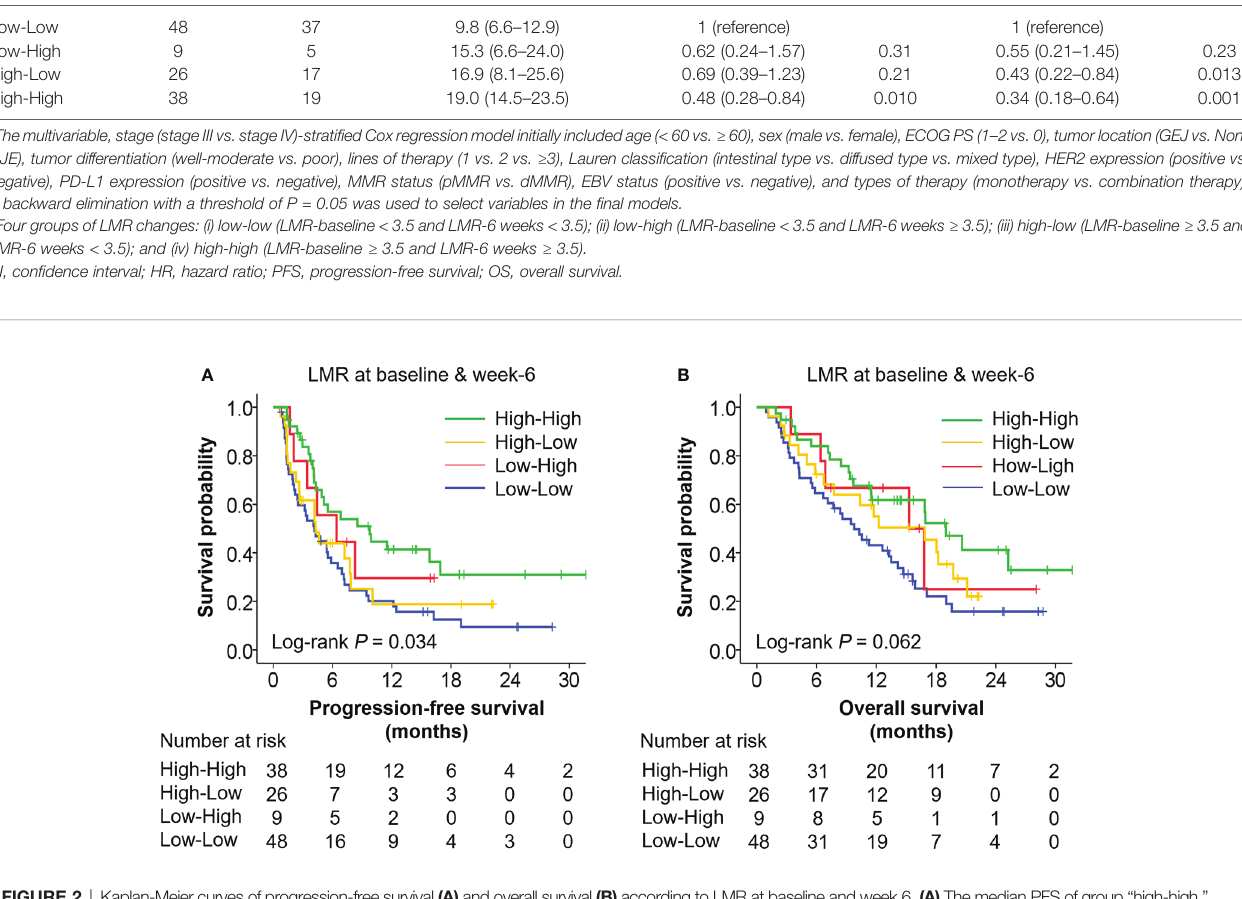
FIGURE 2 | Kaplan-Meiercurvesofprogression-freesurvival (A) andoverallsurvival (B) accordingtoLMRatbaseline andweek6. (A) ThemedianPFS ofgroup “ high-high, ” “ high-low, ”“ low-high, ” and “ low-low ” were9.8 months(95% CI: 3.8 – 15.7),4.3months (95%CI:2.1 – 6.5),6.4months (95%CI:0.6 – 12.2), and4.2months (95%CI:2.2 – 6.2), respectively. (B) ThemedianOS ofgroup “ high-high, ”“ high-low, ” “ low-high, ” and “ low-low ” were19.0months(95% CI:14.5 – 23.5), 16.9months (95%CI:8.1 – 25.6), 15.3 months(95%CI: 6.6 – 24.0),and9.8 months(95% CI: 6.6 – 12.9),respectively. The P